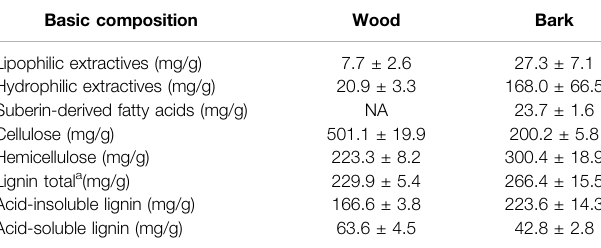
TABLE 2 | Basic wood chemical composition of the wood and bark biomass fractions (mean ± SD, n = 6) of Populus tremula L. × Populus tremuloides Michx.